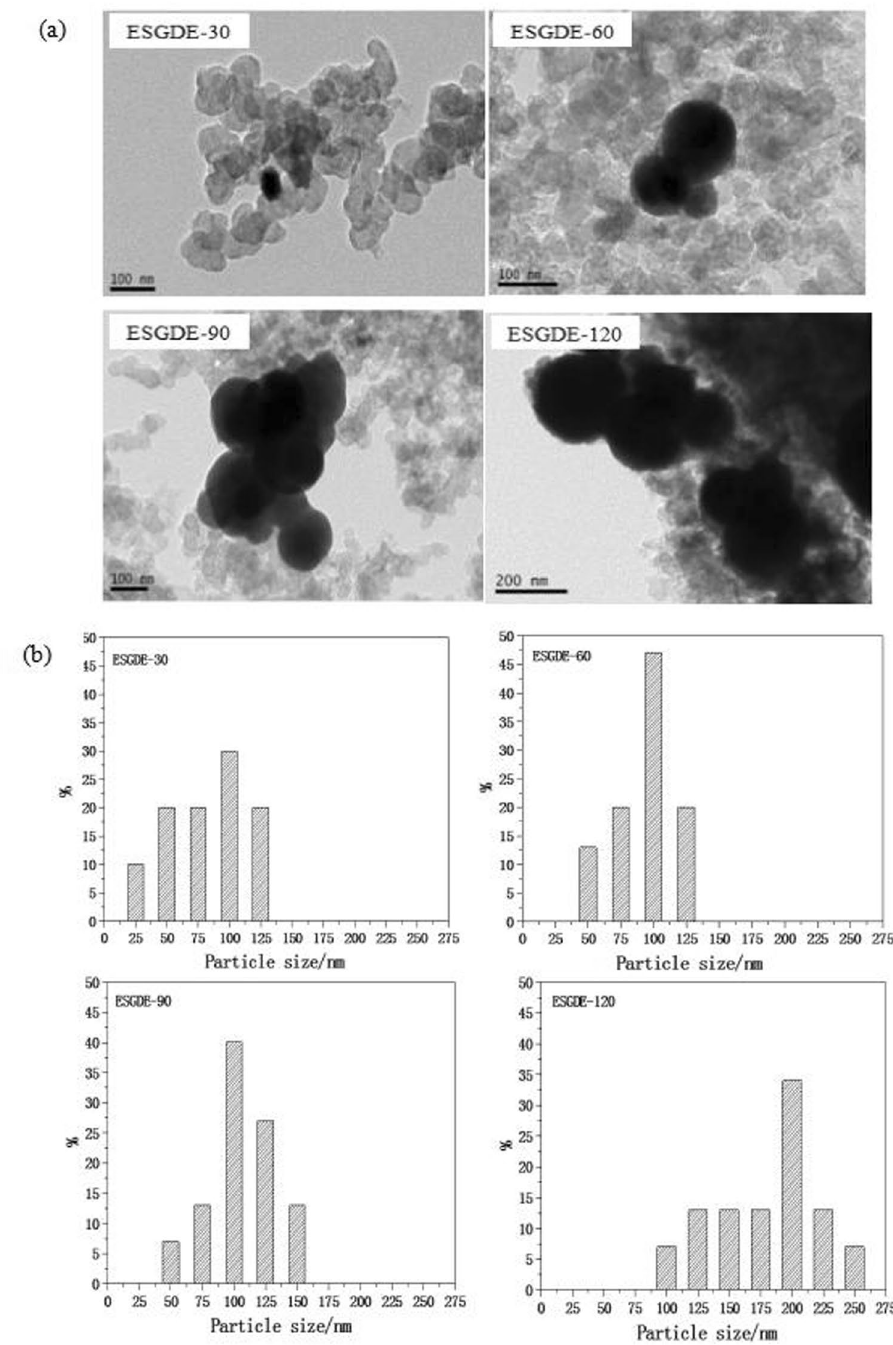
Figure 3. ( a ) TEM of the Sn particles in the ESGDEs with different electrodeposition time. ( b ) Particle size distributions of the Sn particles in the ESGDEs with different electrodeposition time. Distribution plots were calculated based on several TEM